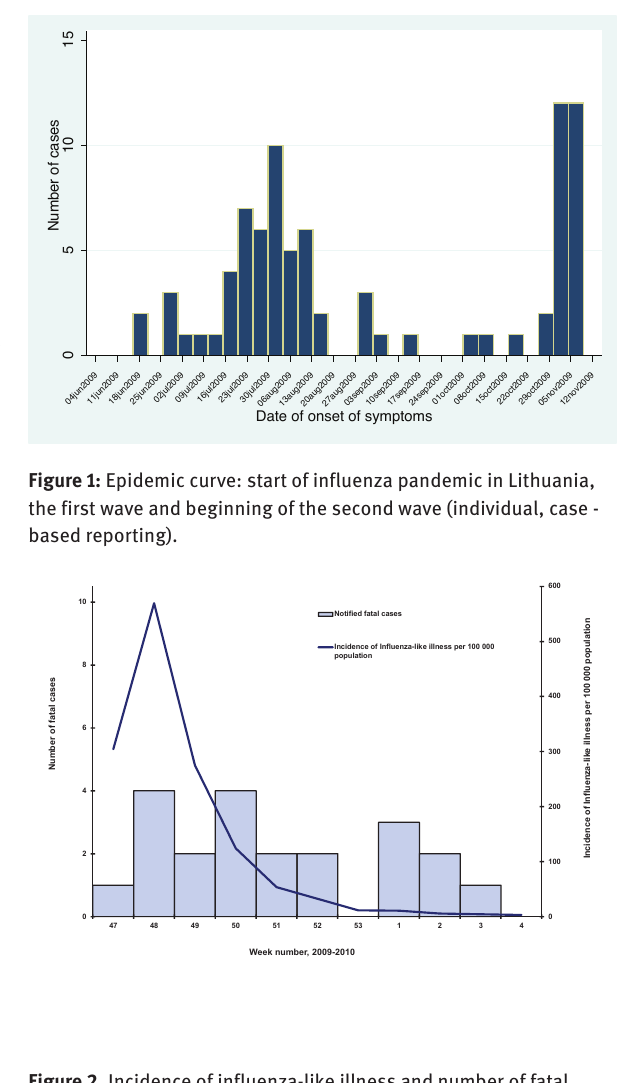
Figure 2. Incidence of influenza-like illness and number of fatal cases from week 47 of 2009 to week 4 of 2010 (aggregate